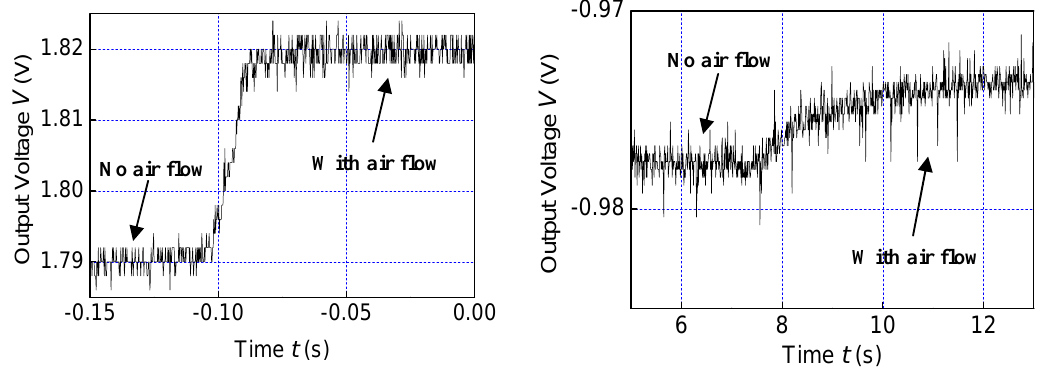
Figure 5. (a) Time response curve of the coated MSCNTS-HWFS and (b) time response curve of the